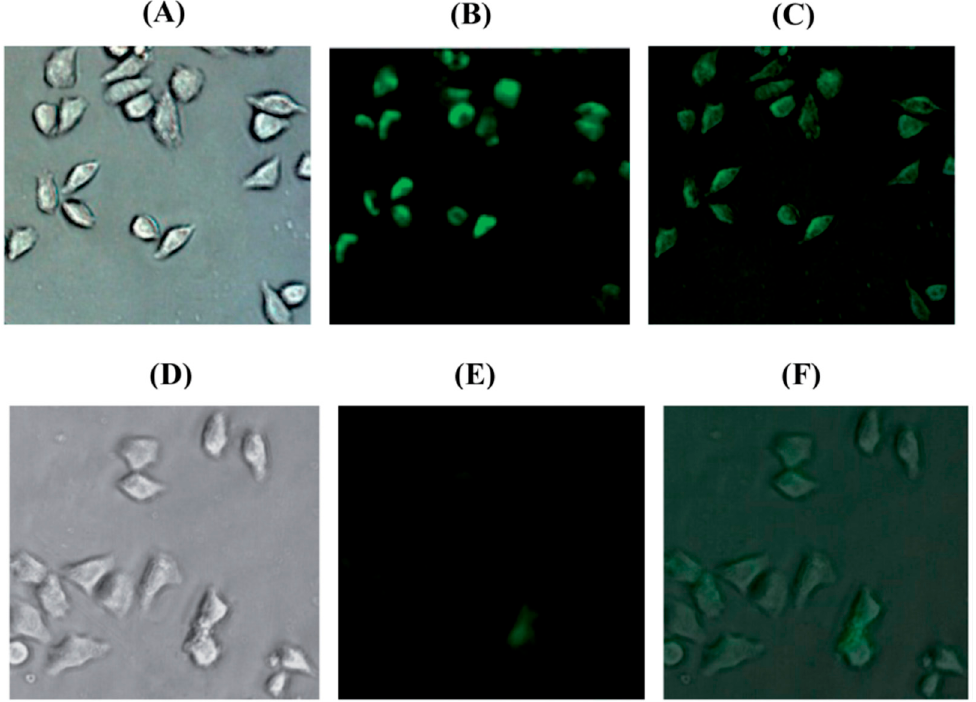
Figure 4. Images of HeLa cells after incubation with FONs (fluorescent organic nanoparticles) 50 . ( A ) Bright-field image of HeLa cells incubated with Fe 3+ /FONs (10 mM); ( B ) fluorescence image of ( A ); ( C ) the overlay image of ( A ) and ( B ); ( D ) bright-field image of HeLa cells incubated with FONs (10 mM); ( E ) fluorescence image of ( D ); ( F ) the overlay image of ( D ) and ( E ). The fluorescence images were acquired with green light excitation (Reproduced from Ref. [57] with permission from The Royal Society of Chemistry).